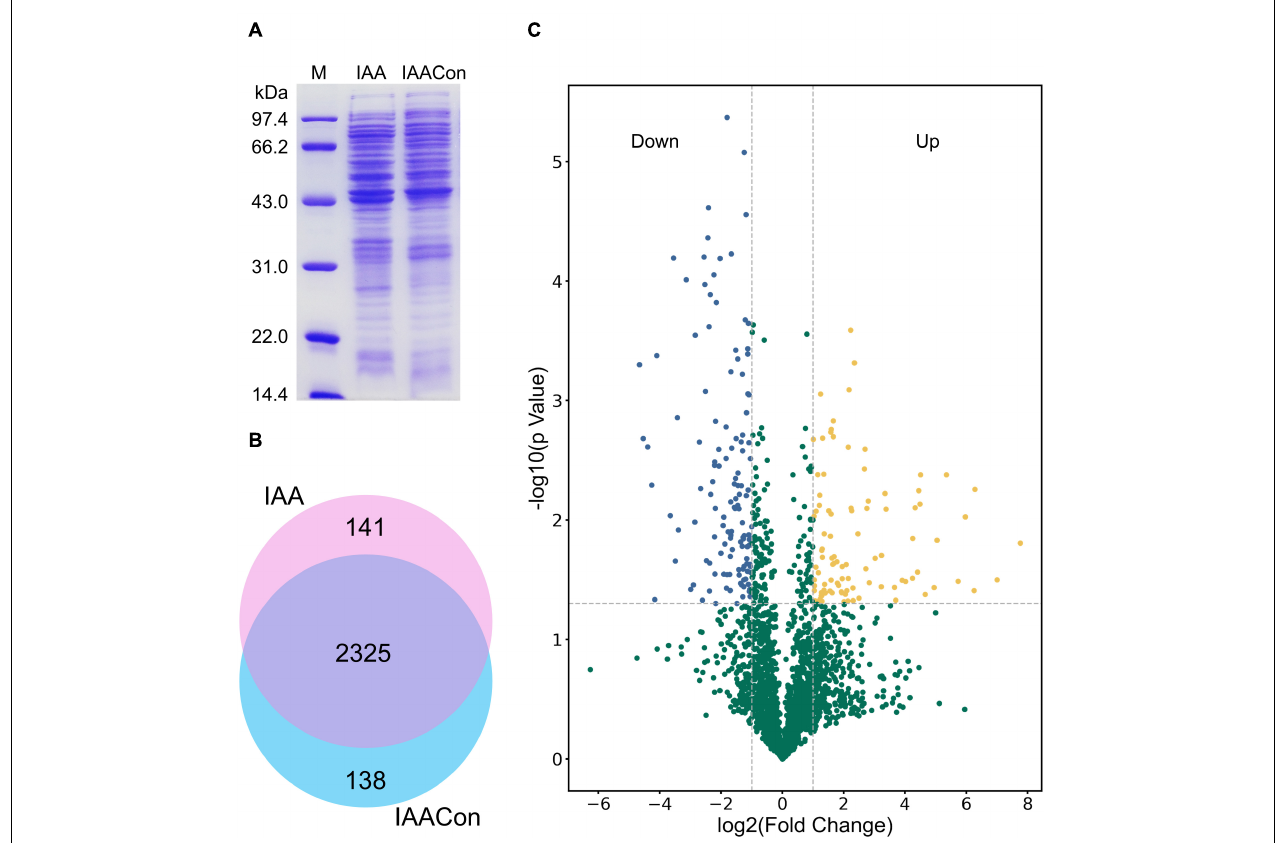
FIGURE 2 | SDS-PAGE, Venn diagram, and volcano plot of the proteomic dataset. (A) SDS-PAGE analysis of crude proteins extracted from cell of IAA group (cultivated with IAA) and IAACon group (cultivated with citrate/NH 4 Cl). (B) Venn diagram of proteins identified in the proteomes of IAA and IAACon group. (C) Volcano plot showing changes in protein abundance from IAA and IAACon